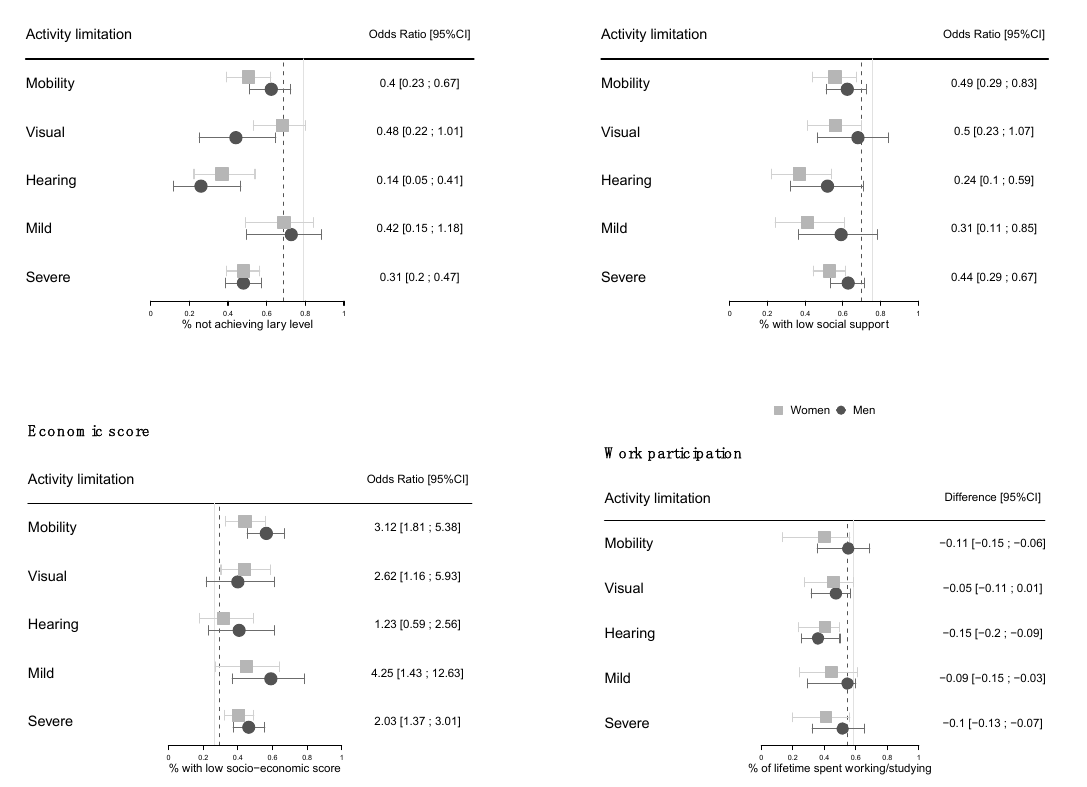
Figure 2. Association between disability and education level, economic status, availability of social support and participation to work by sex and type of activity limitation. Odds ratios and differences compare participants with and without disabilities of same sex, age and residential area. Vertical lines represent proportion among participants without disability (plain line: women, dotted line: men).